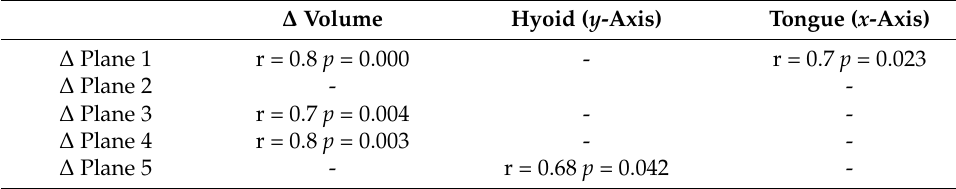
Table 7. Correlation between the cross-sectional area and skeletal